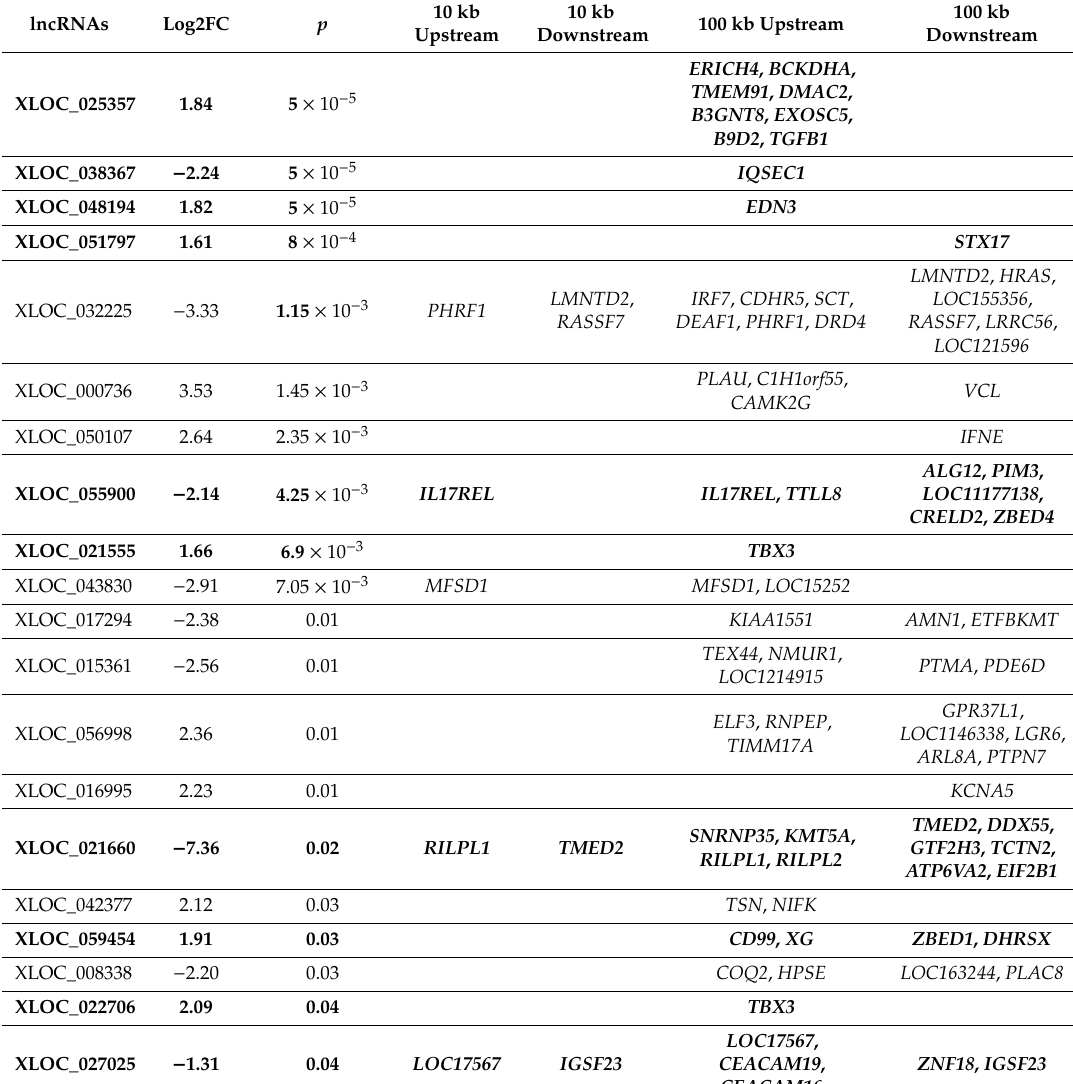
Table 2. Significant di ff erentially expressed lncRNAs and their targeted